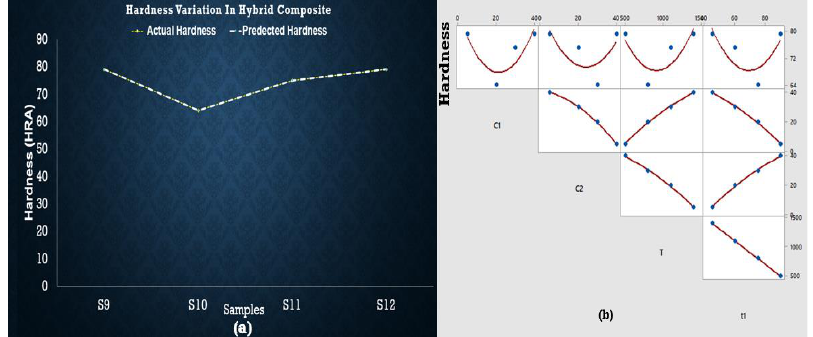
Figure 7. ( a ) Regression plot for Al-SiC-ZrSiO 4 showing overlapping of actual and predicted hardness values points (yellow dotted line presents actual value of hardness and white line shows predicted values). ( b ) Matrix plot showing the individual relationship between hardness and input variables for Al-SiC-ZrSiO 4 .